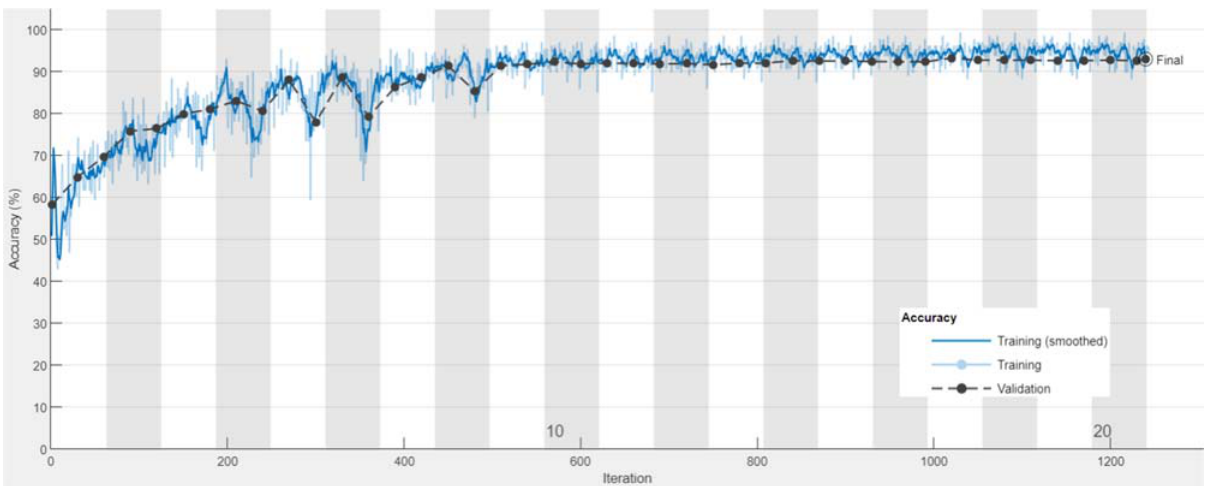
Fig. 11. Accuracy changes in CNN training